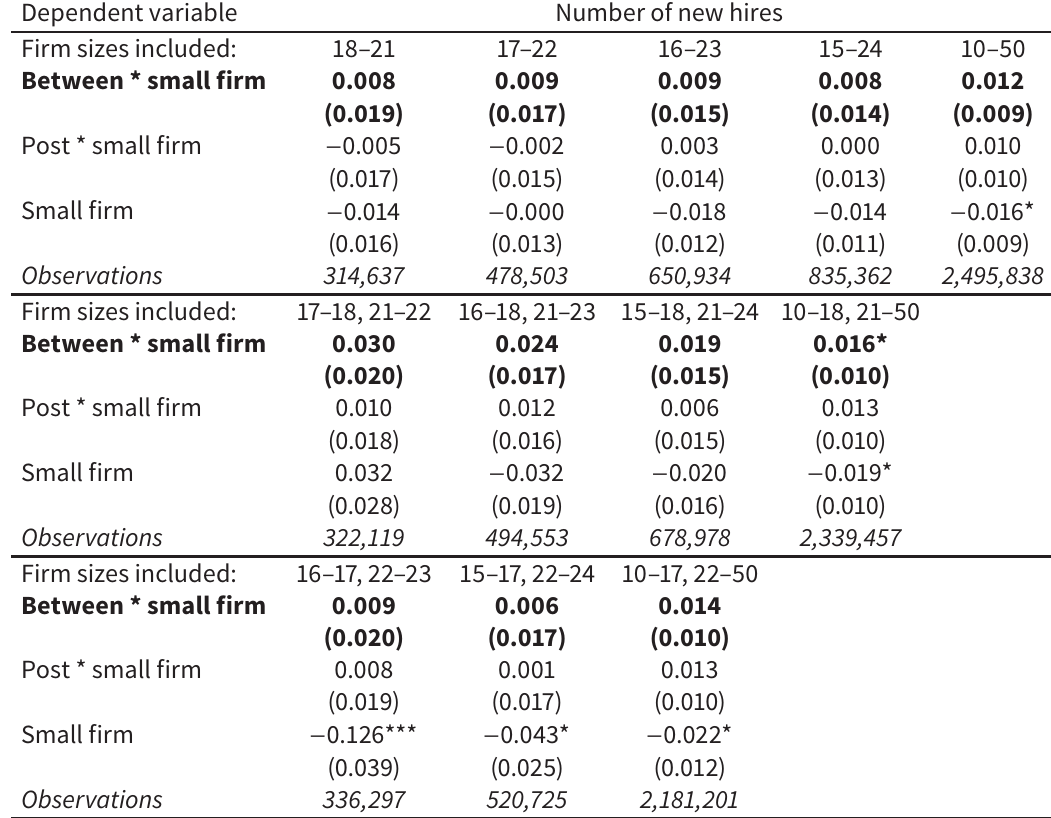
Policy effect on the number of new hires, varying firm sizes included Dependent variable